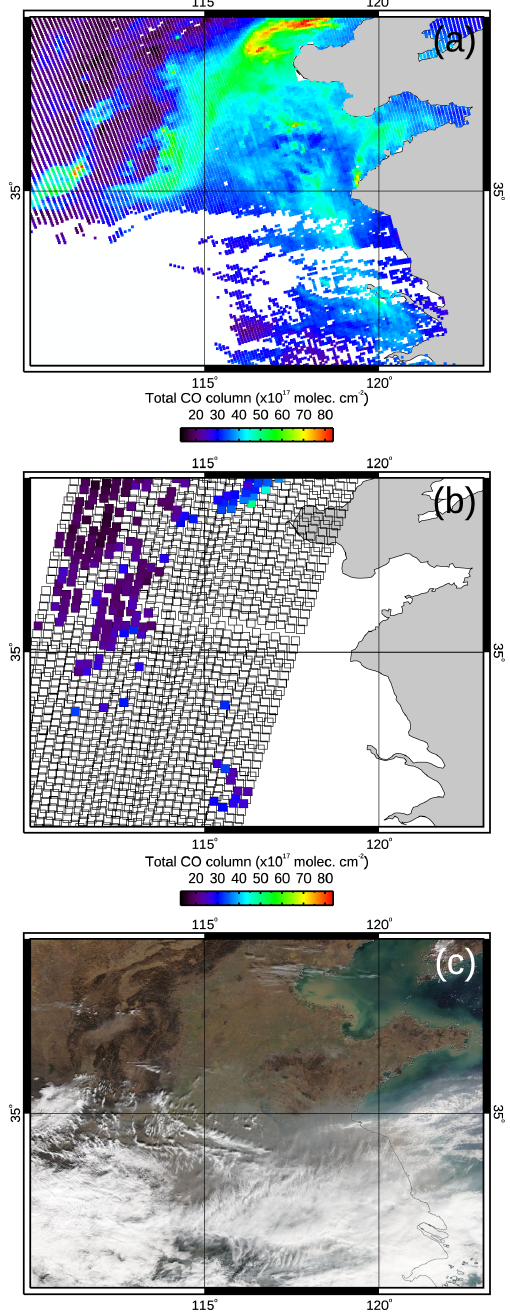
Figure 14. Total CO column retrievals and visible image for the China ROI on 1 January 2018. (a) TROPOMI map. (b) MOPITT TIR + NIR map. (c) Terra-MODIS visible image acquired at the same time as the MOPITT data. Empty boxes in panel (b) corre- spond to MOPITT observations deemed cloudy based on MODIS cloud mask information and are thus not suitable for CO retrieval. The MODIS visible image shows clouds in the southern half of the ROI; the northern half was hazy, most probably due to pollution, but